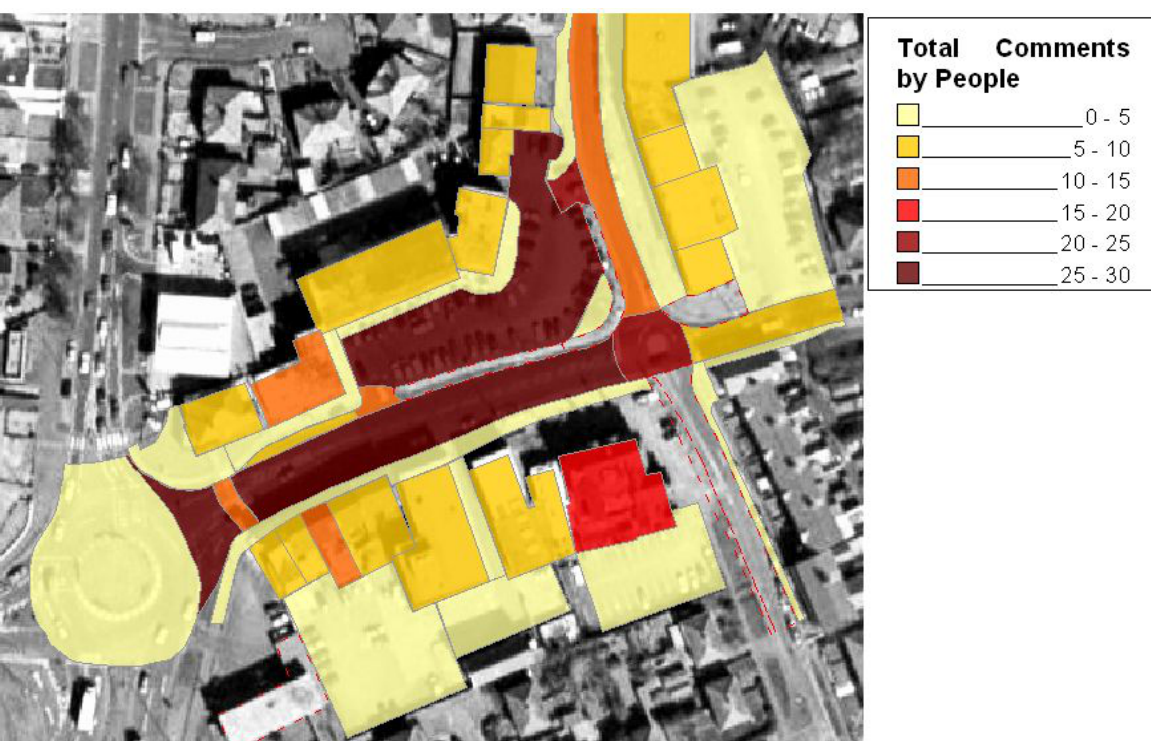
Figure 14. Intensity of problems by area in the local community Source: Cinderby and Forrester (2008), Figure